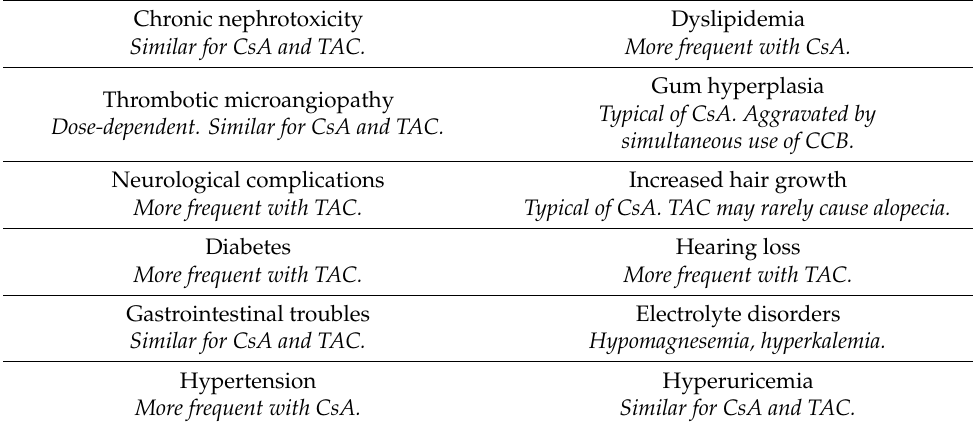
Table 3. Main complications of